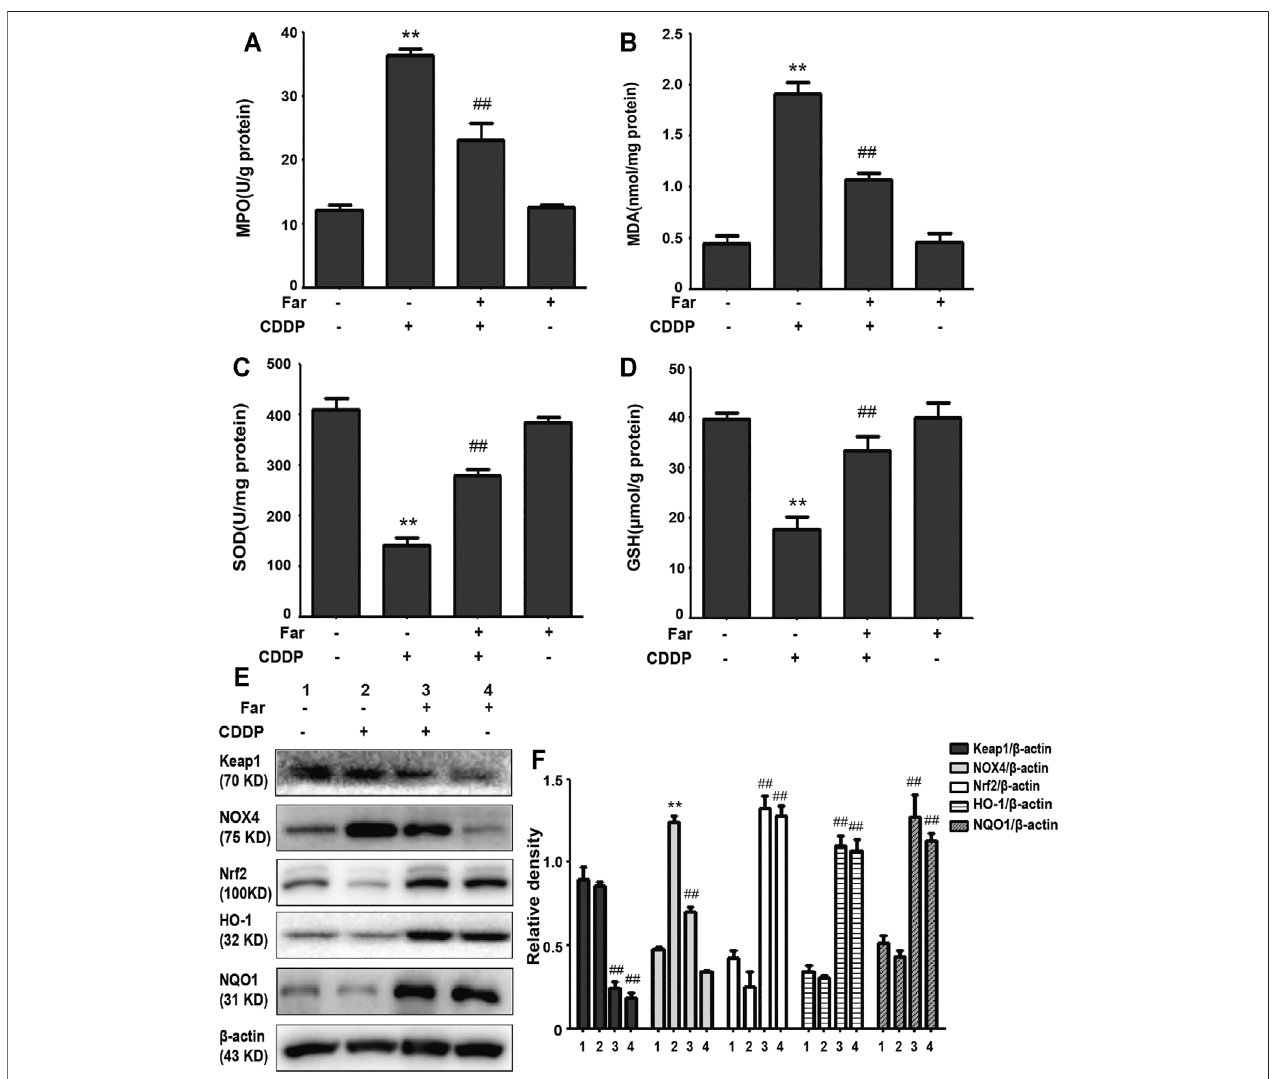
FIGURE 3 | Farrerol alleviatescisplatin-induced oxidative stress in vivo . (A – D) Mice were sacri fi ced on the 38th day after the fi rst cisplatin administration, and renal tissues were collected. The contents of MPO, MDA, SOD, and GSH in kidney tissue were measured. Data are expressed as the mean ± SEM ( n (cid:1) 6 per group). (E,F) Kidney tissue lysates were analyzed by immunoblotting with speci fi c antibodies against Keap1, NOX4, Nrf2, HO-1, and NQO1. The expression levels of the abovementioned oxidation pathway-related proteins were quanti fi ed by densitometry and standardized to β -actin. Data are expressed as the mean ± SEM. * p < 0.05 and ** p < 0.01 compared with the control group; # p < 0.05 and ## p < 0.01 compared with the CDDP group.